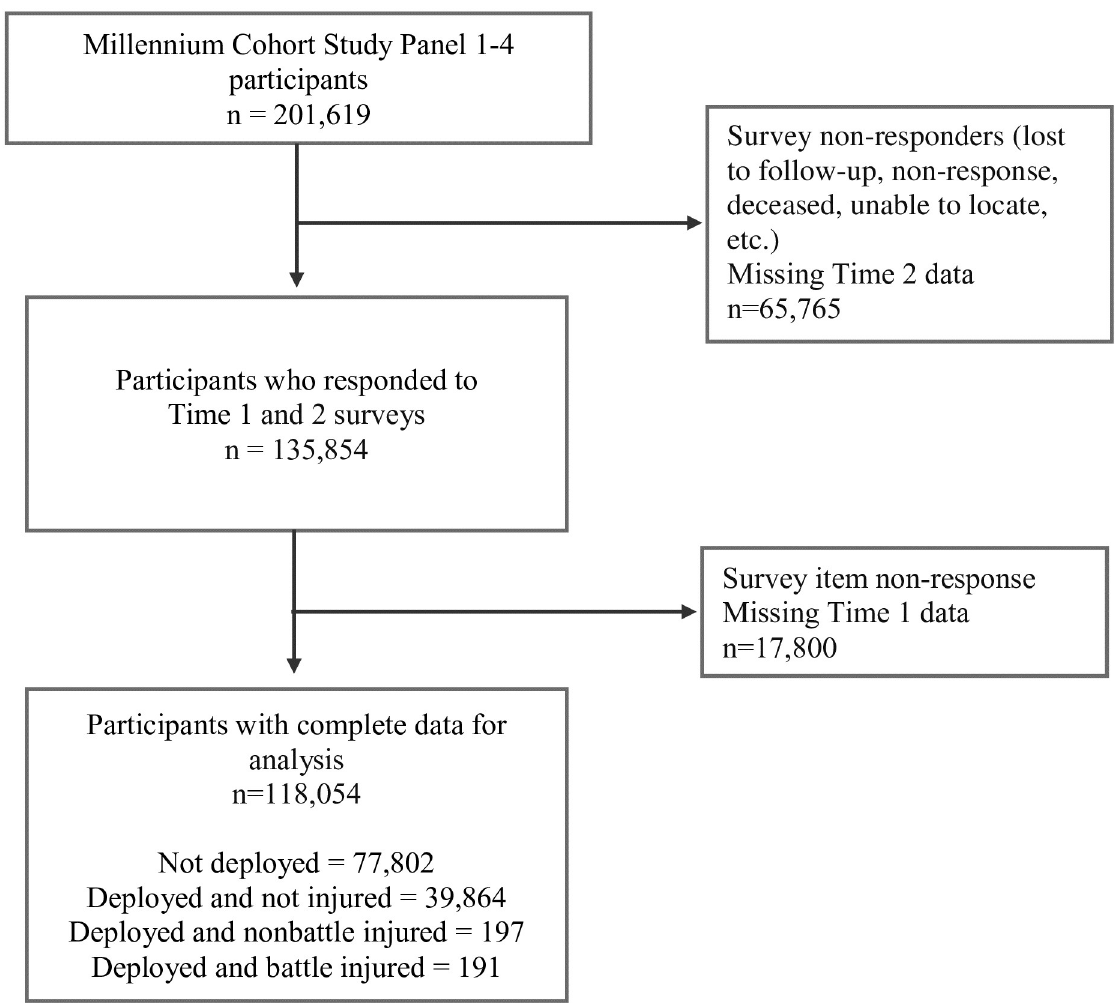
Fig 2. Flow chart of inclusion criteria for the deployment and injury status on quality of life